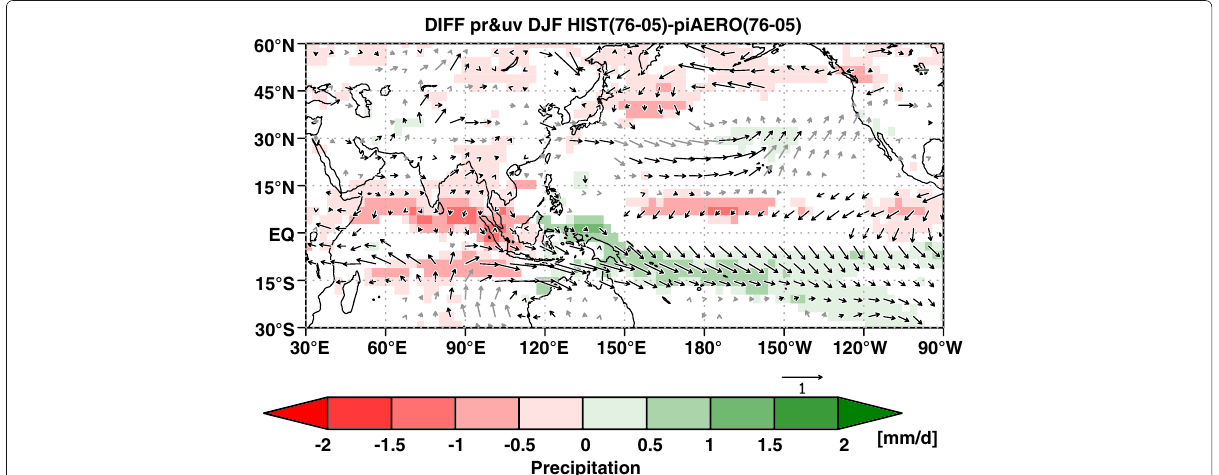
Fig. 8 As in Fig. 6, but during DJF. The unit of precipitation (wind) is mm day − 1 (m s − 1 ). Gray vectors represent the spatial pattern of differences in wind, which are not statistically significant. Only stronger differences (>0.2 m s − 1 ) are